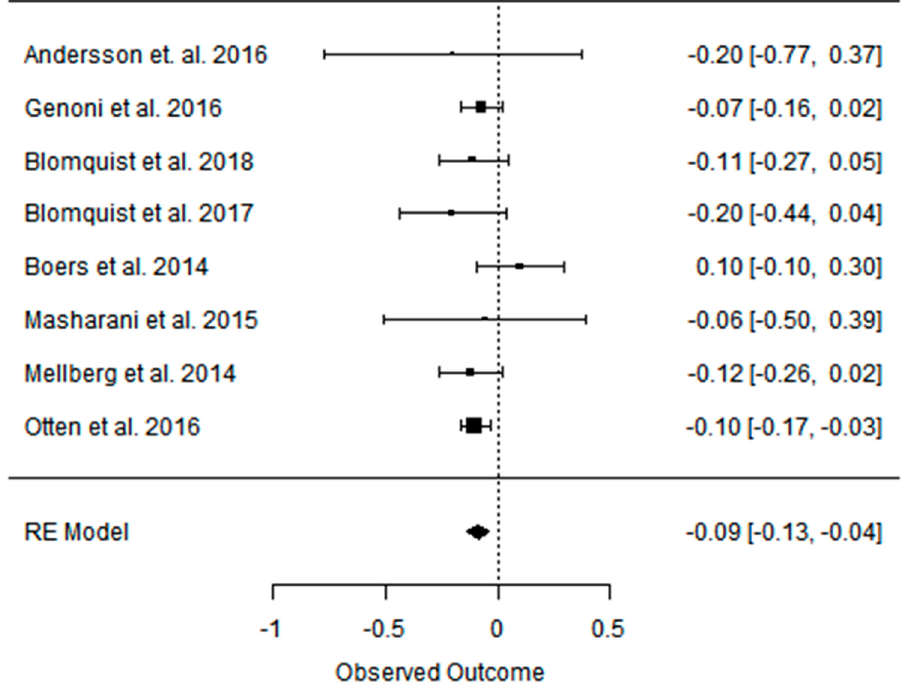
Figure A19. Forest plot of the effect of a CD on TG in the short term (weighted mean difference).